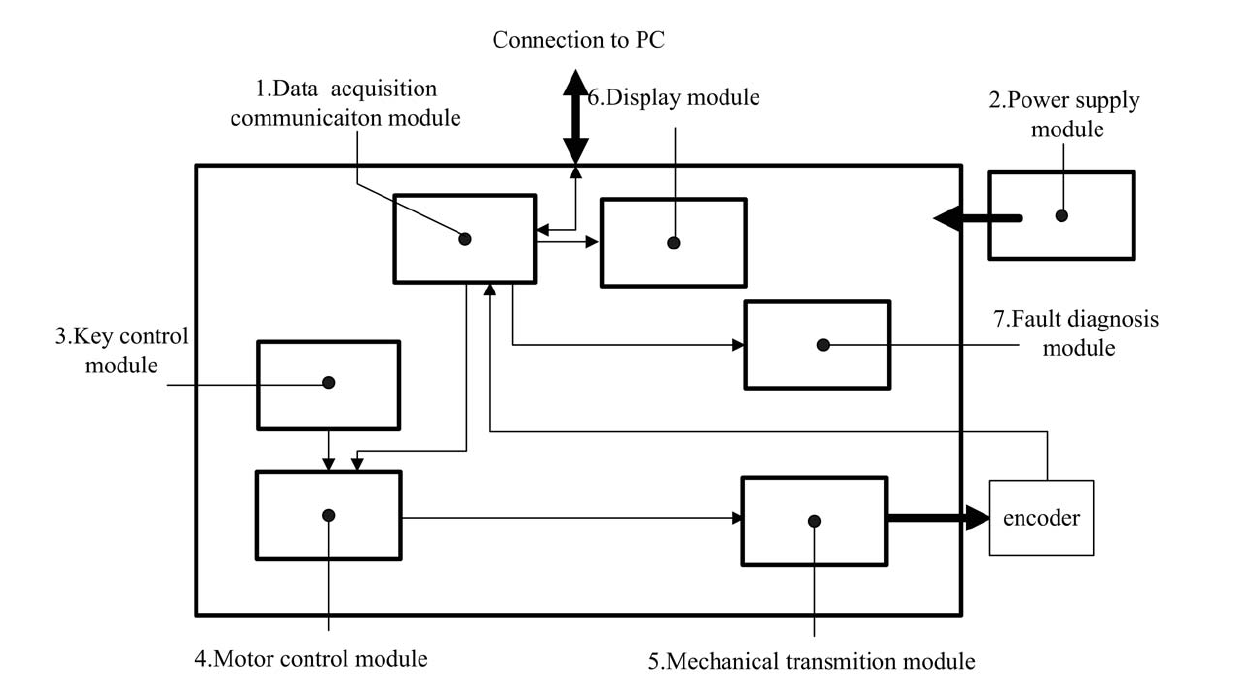
Figure 4. The block diagram of the test